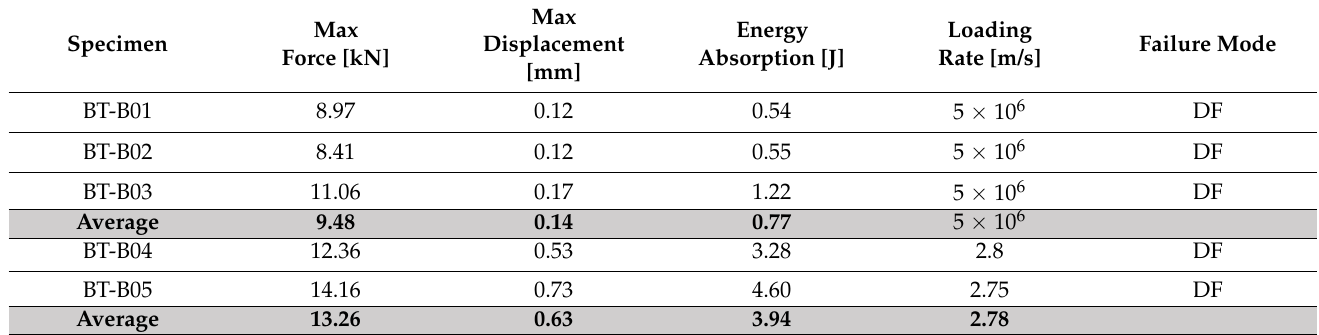
Table 2. Results of the multi-material bonded joints (DF—delamination failure).